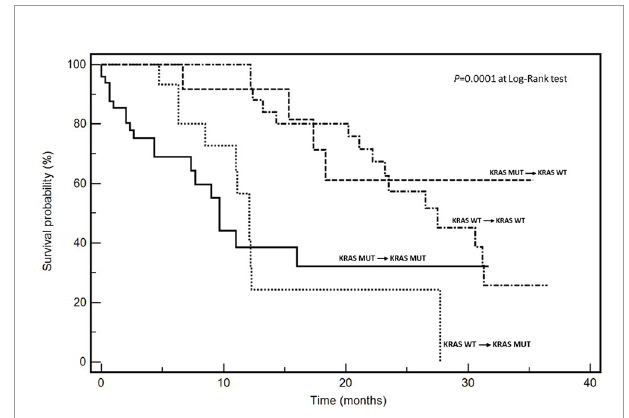
FIGURE 1 | Kaplan-MeiersurvivalcurvesaccordingtoKRASmutationaltrajectories.